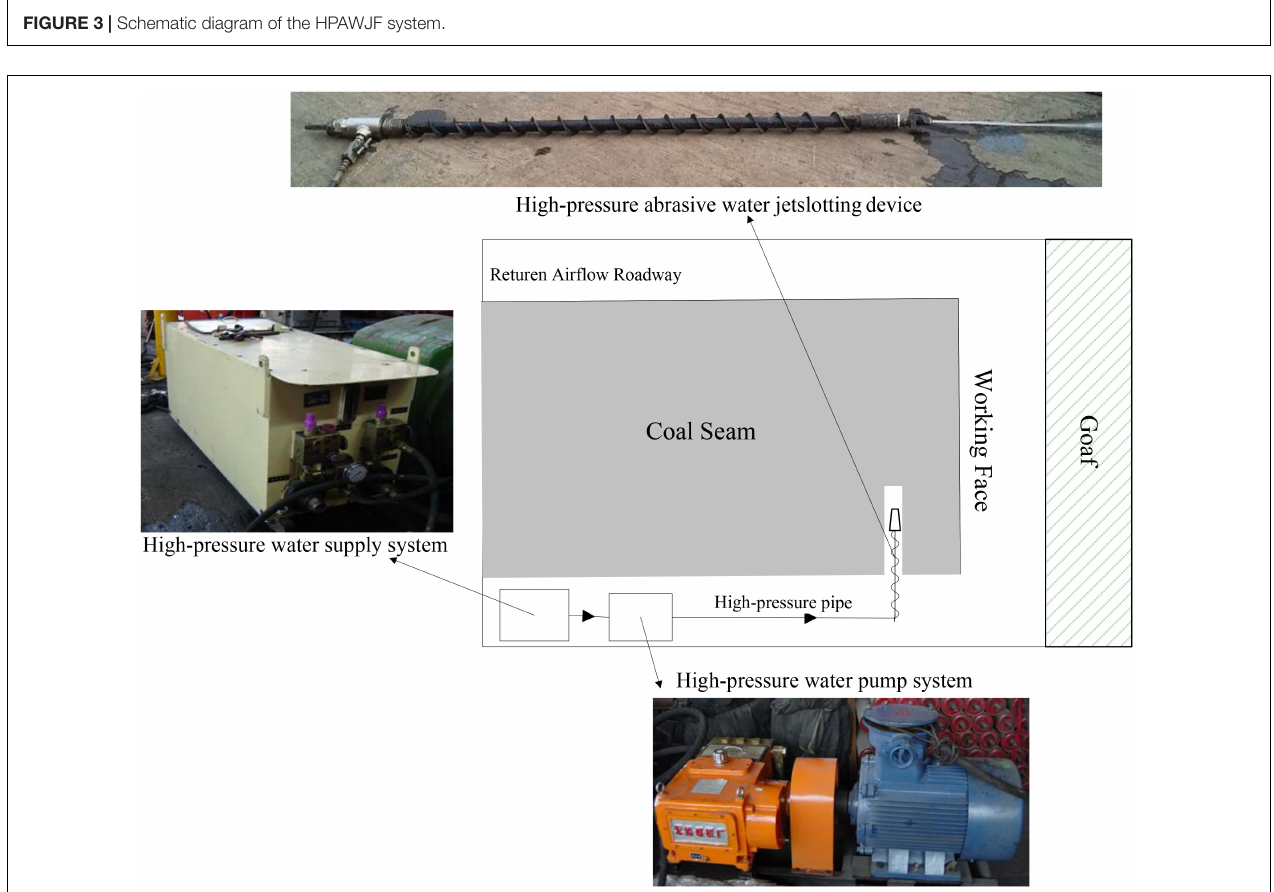
FIGURE 4 | The main devices and arrangement